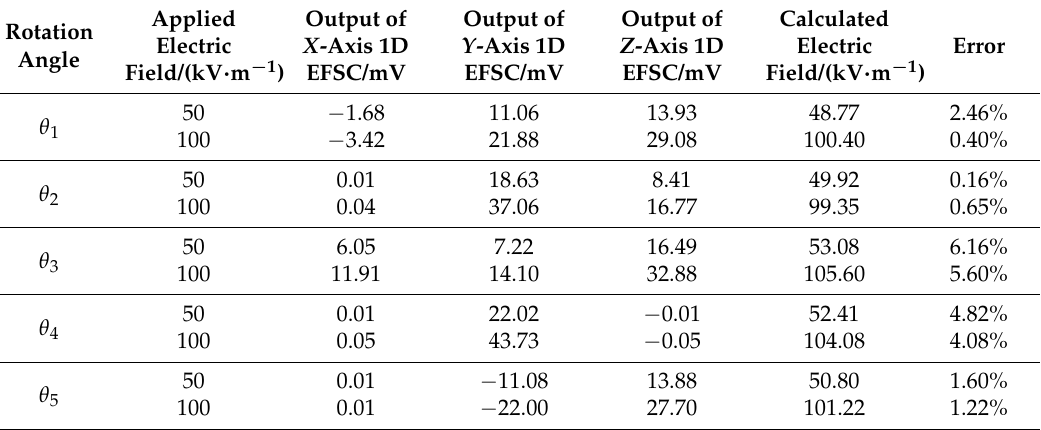
Table 4. Outputs of the 3D EFS and calculated electric